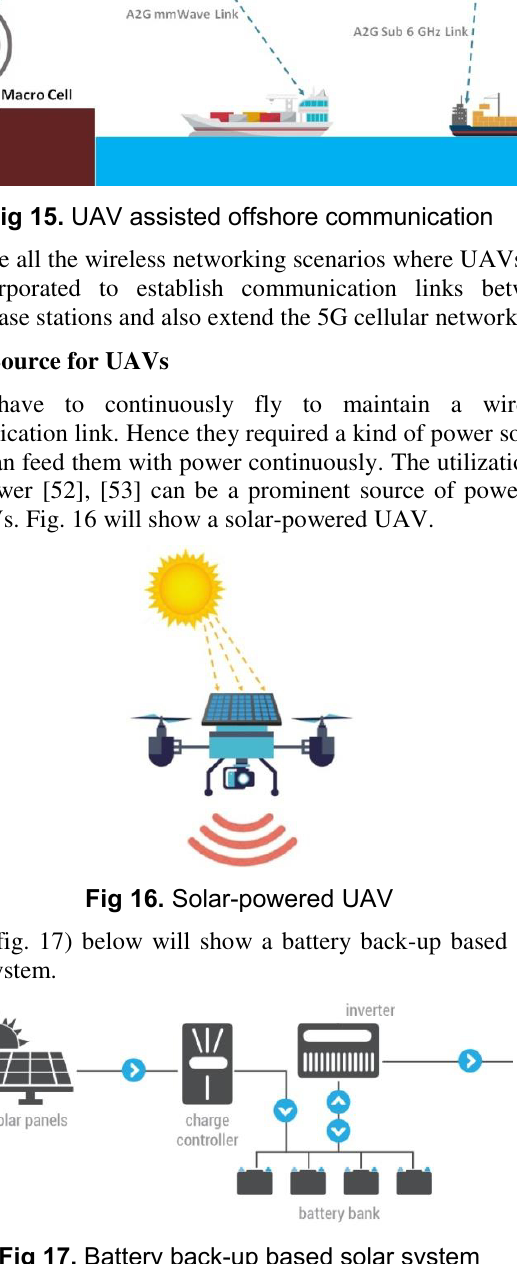
Fig 17. Battery back-up based solar system